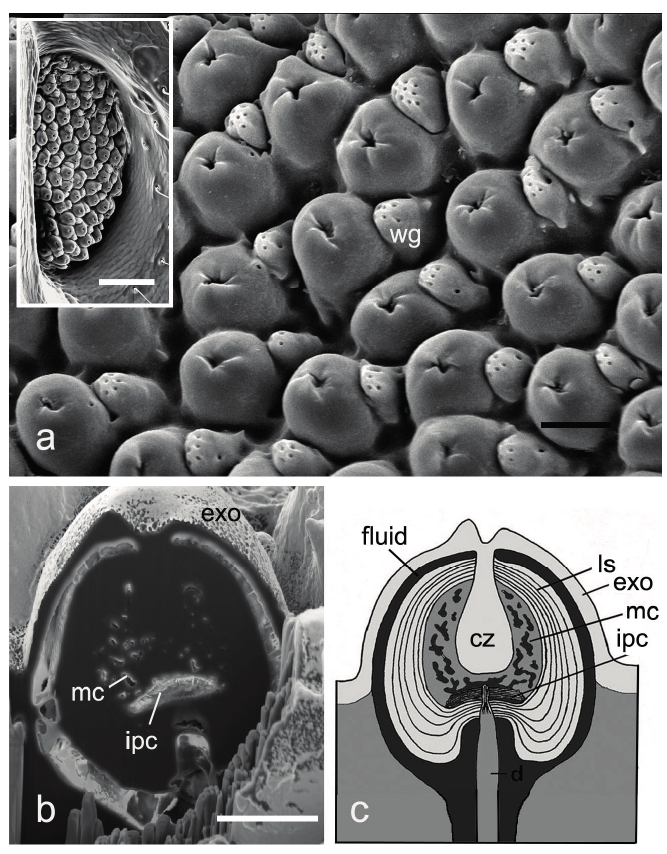
Figure 1. Infrared (IR) organ of Melanophila acuminata . ( a ) Dome-shaped IR sensilla at the bottom of a pit organ (whole organ shown in the inset). Each sensillum is accompanied by a smaller wax gland (wg) characterized by tiny pores. Bar: 15 µm (Inset 100 µm). ( b ) Single IR sensillum centrally opened by focused ion beam (FIB). Specimen was air-dried; therefore only the cuticle is preserved. Microcavities (mc) of the intermediate layer and the inner pressure chamber (ipc) can be discerned inside the sphere. exo: exocuticular outer dome. Bar: 5 µm. ( c ) Schematic drawing of a photomechanic IR sensillum covered